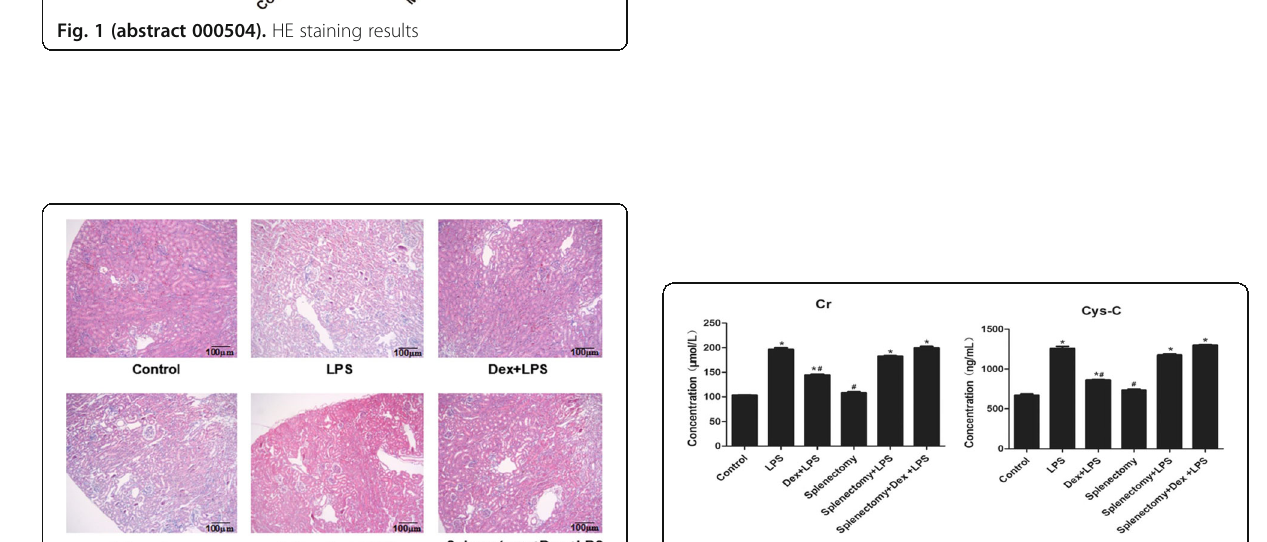
Fig. 4 (abstract 000504). Tunel apoptosis results in kidney tissues of each